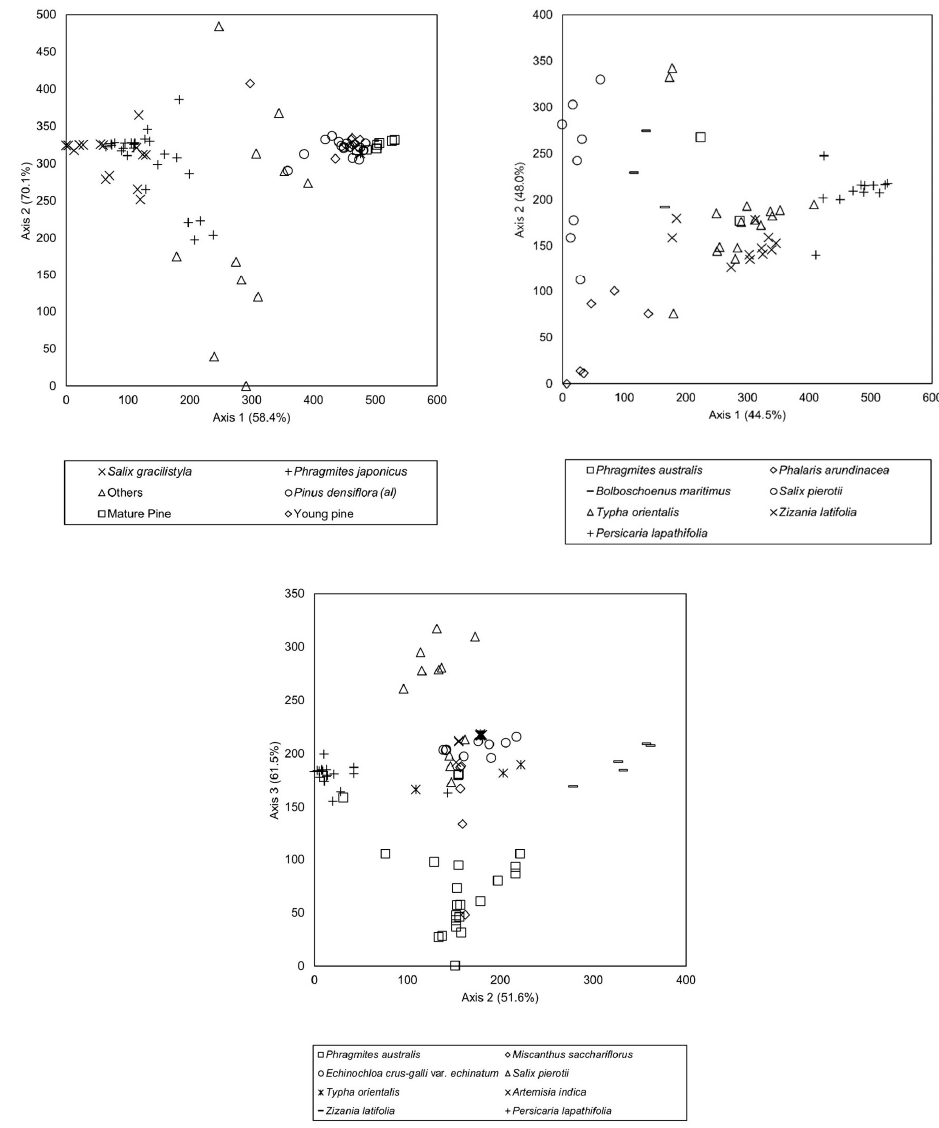
Figure 5. DCA ordination of stands based on vegetation data obtained from combining vegetation established on both stream bars and riparian zone of mountain gravel-bed river ( upper left ), lowland river ( upper right ), and estuary ( lower )